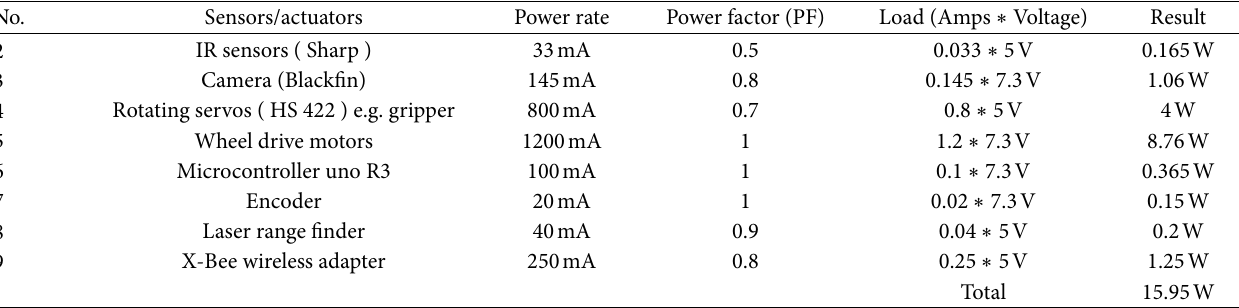
Table 5: Components and loads in robot 4.